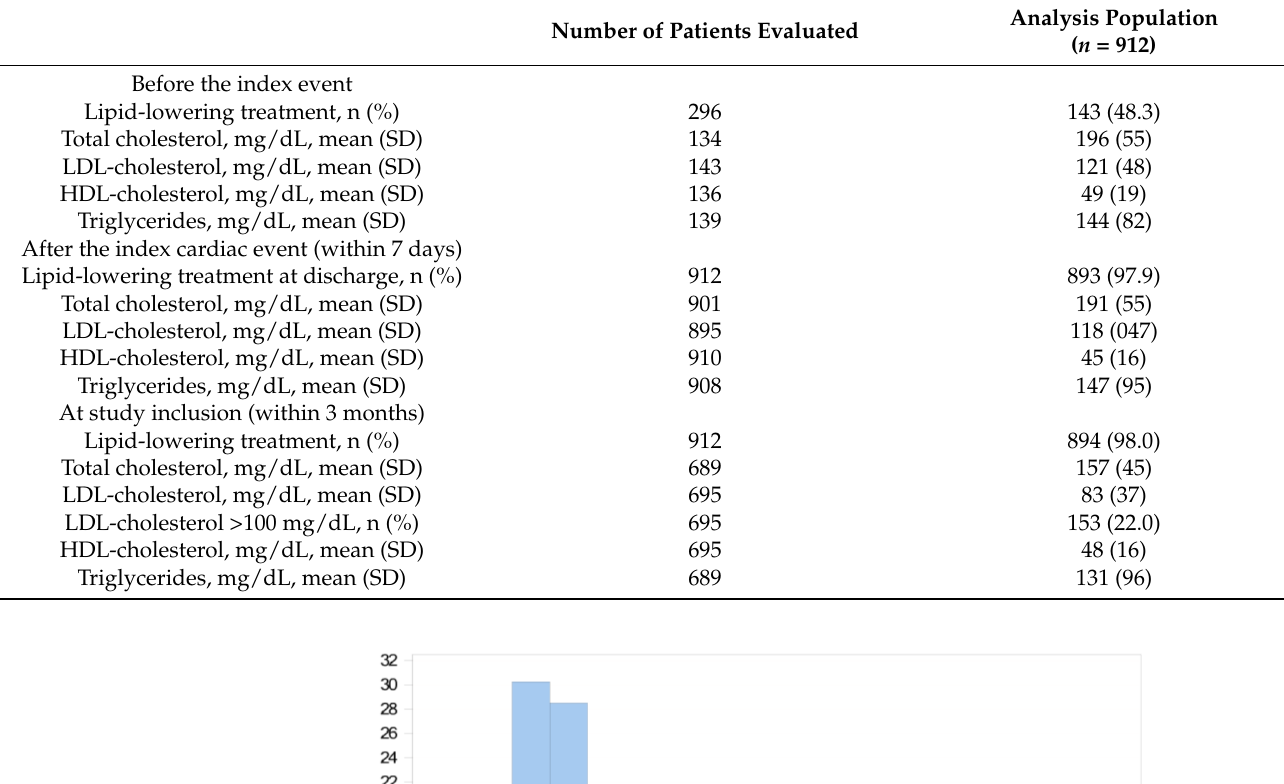
Table 3. Lipid assessment of very high-risk CAD patients before and after the index cardiac event.